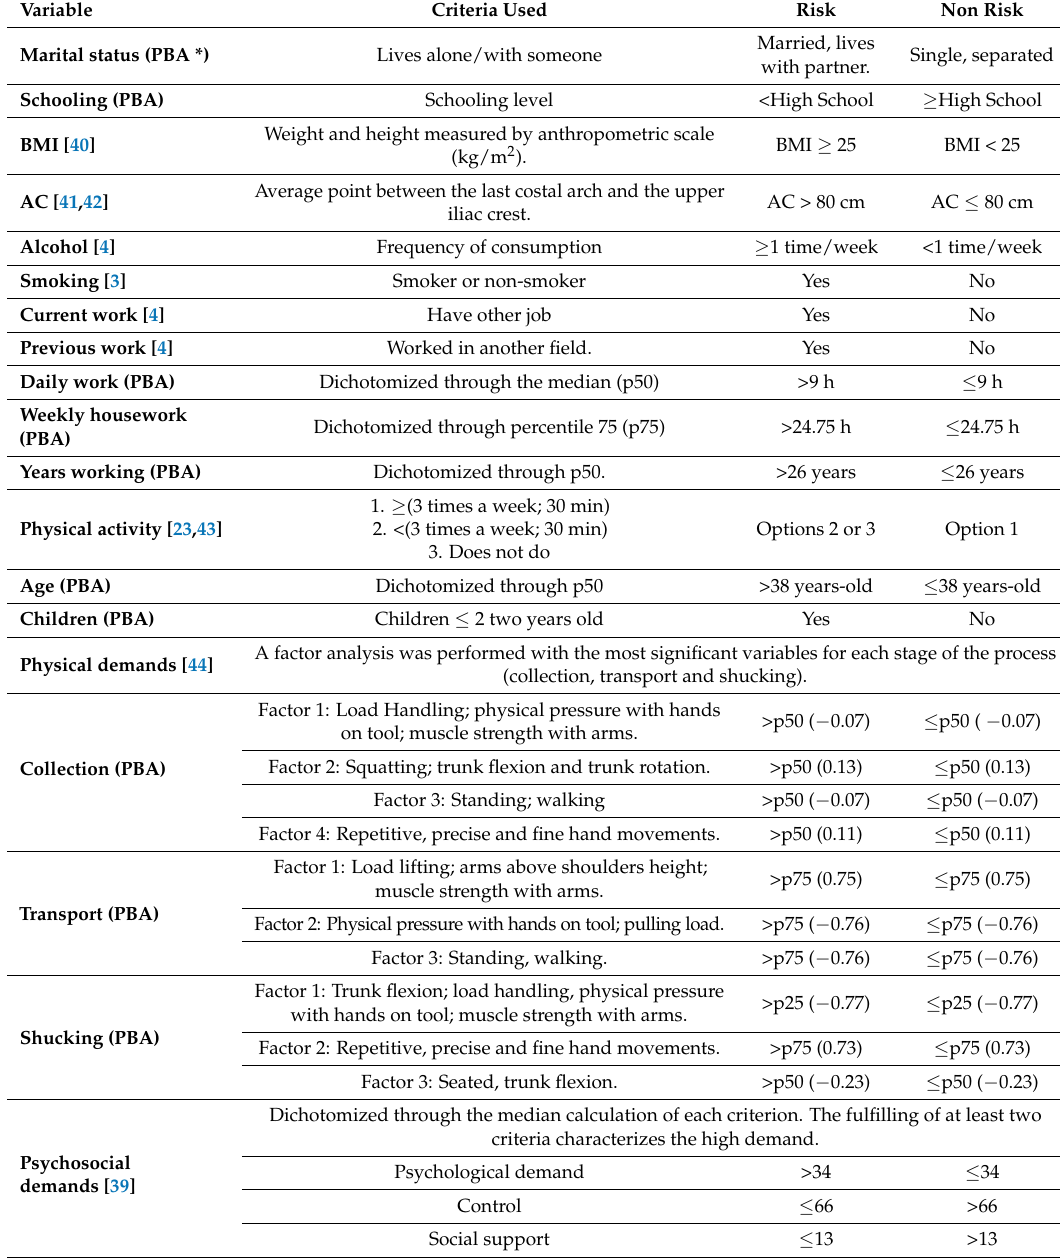
Table 1. Independent variables, categories and classification